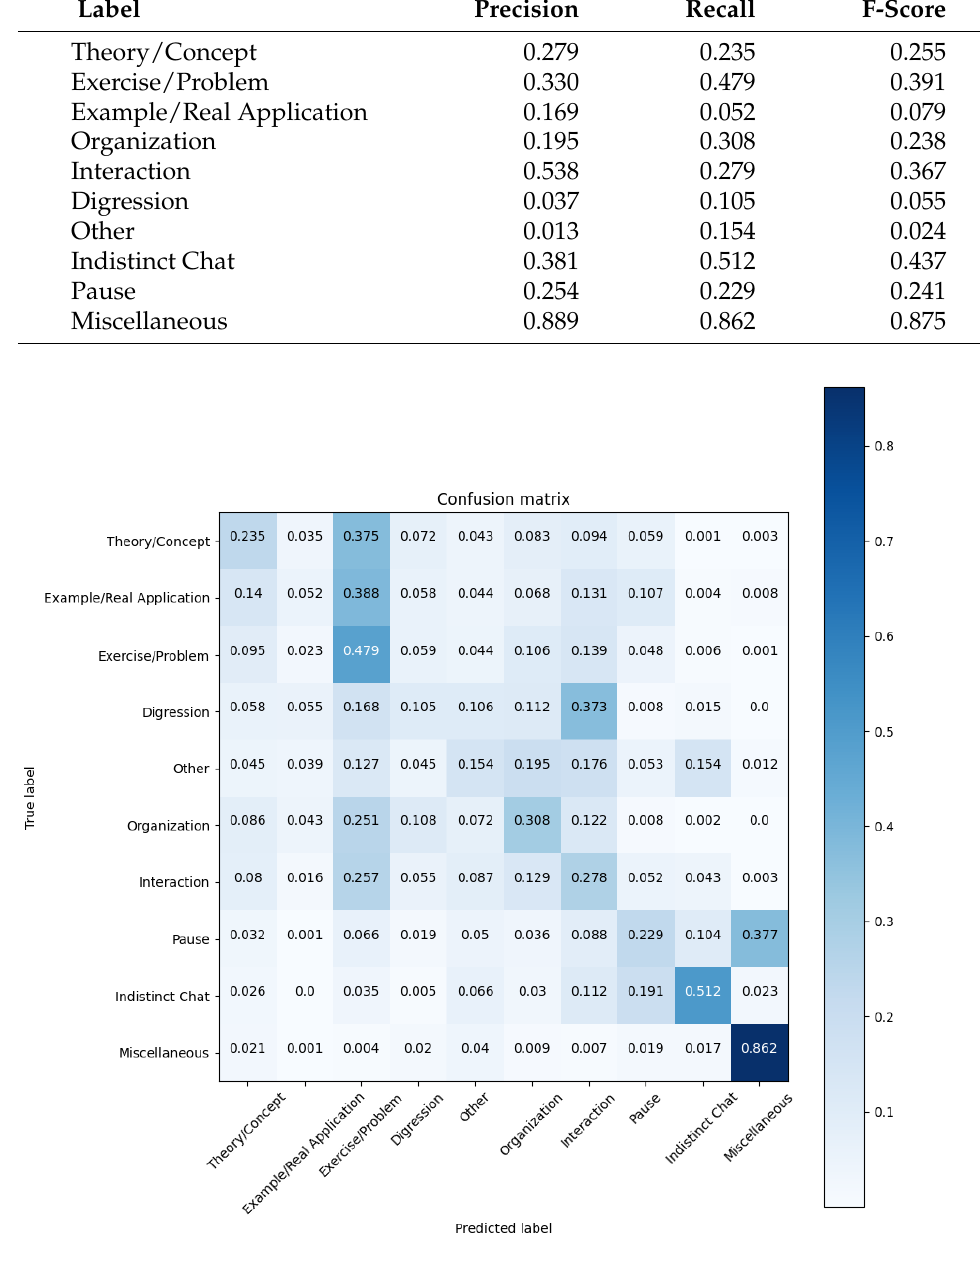
Figure 10. Confusion